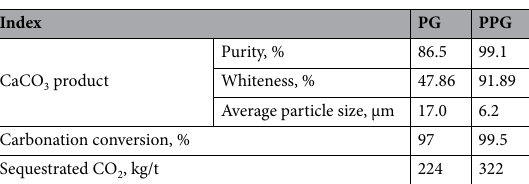
Table 4. Comparison between the CaCO 3 product obtained from PG and the CaCO 3 product generated from PPG through mineral